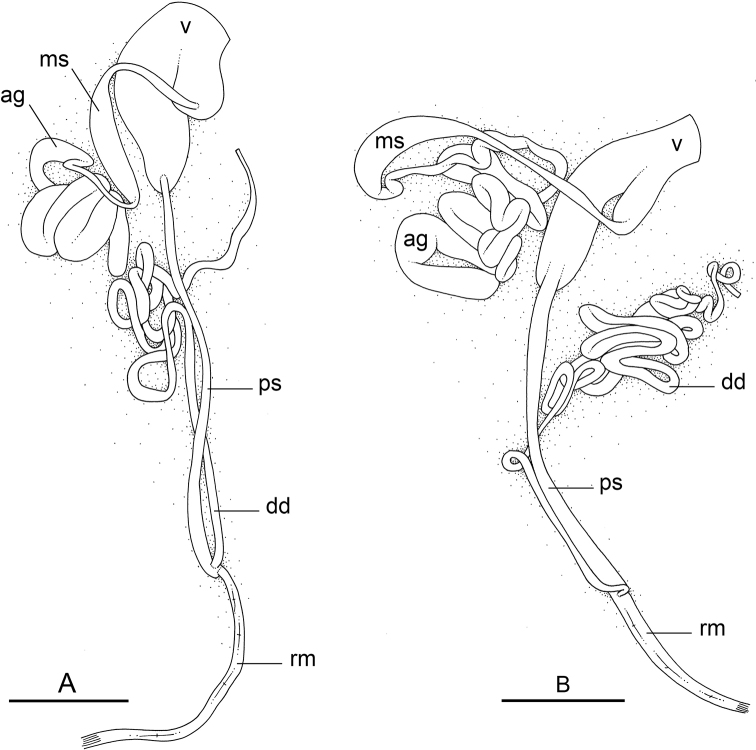
Anterior, male, copulatory apparatus, Peronia
sydneyensisA holotype, Australia, New South Wales, [1516 H] (AM C.468916.001) B New Caledonia, [6195] (MNHN-IM-2019-1595). Scale bars: 3 mm (A, B). Abbreviations: ag accessory penial gland, dd deferent duct, ms muscular sac, ps penial sheath, rm retractor muscle, v vestibule.